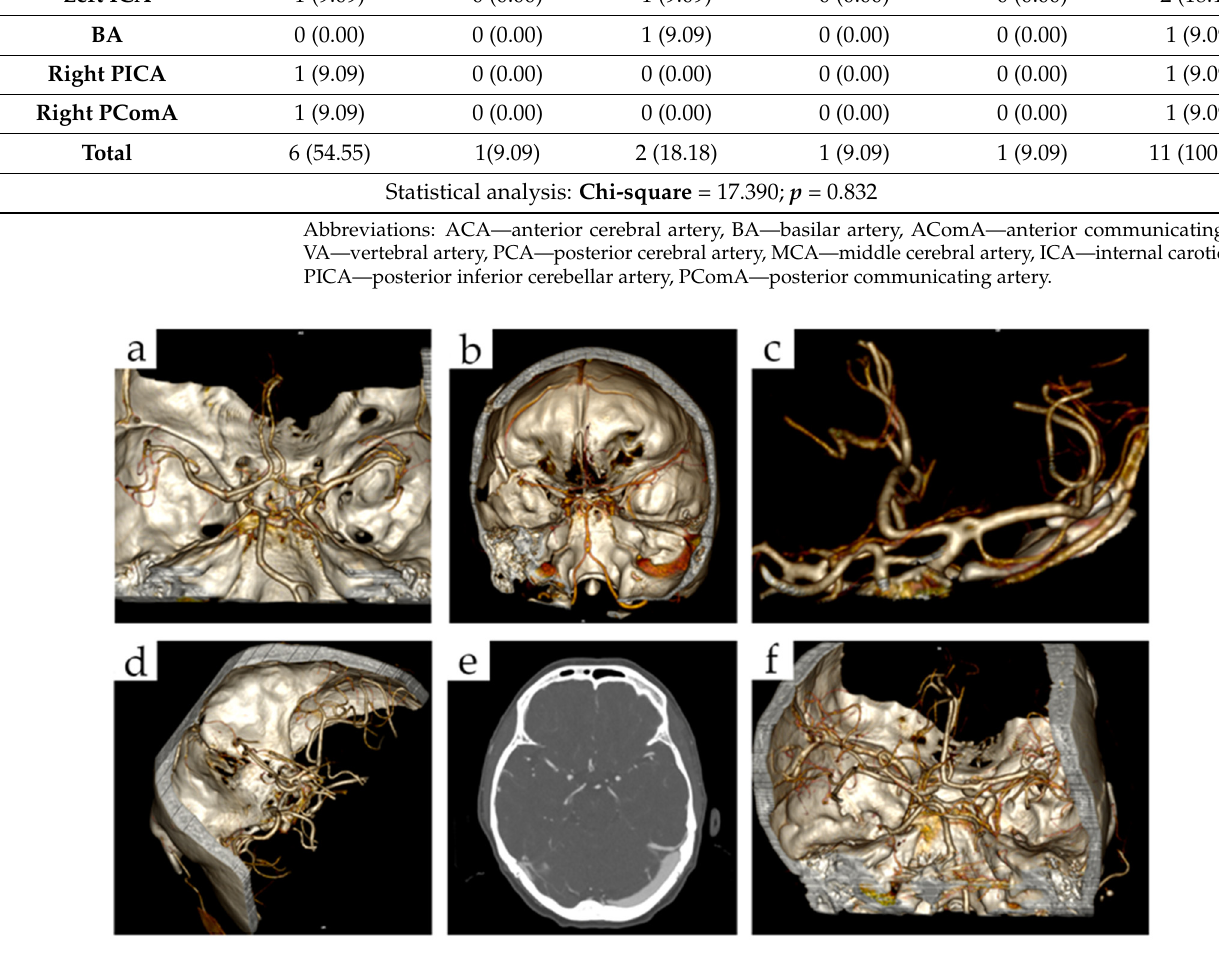
Figure 1. Cerebral arterial fenestrations on CT-3D reconstructions: ( a ) right ACA fenestration, ( b ) BA fenestration, ( c ) left MCA fenestration, ( d ) AComA fenestration, ( e ) AComA fenestration on CT angiography, ( f ) right MCA fenestration. (Abbreviations: ACA—anterior cerebral artery, BA—basilar artery, MCA—middle cerebral artery, AComA—anterior communicating